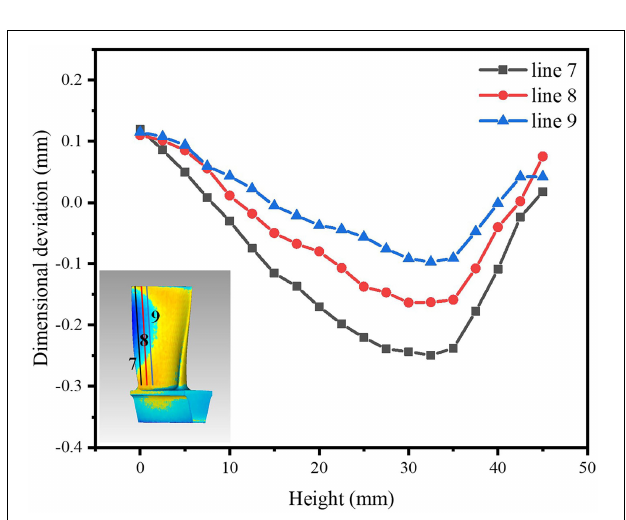
FIGURE 10 | Dimensional deviation analysis at the trailing edge of seven blades samples (27.5, 30, 32.5, 35, 37.5, 40, and 42.5